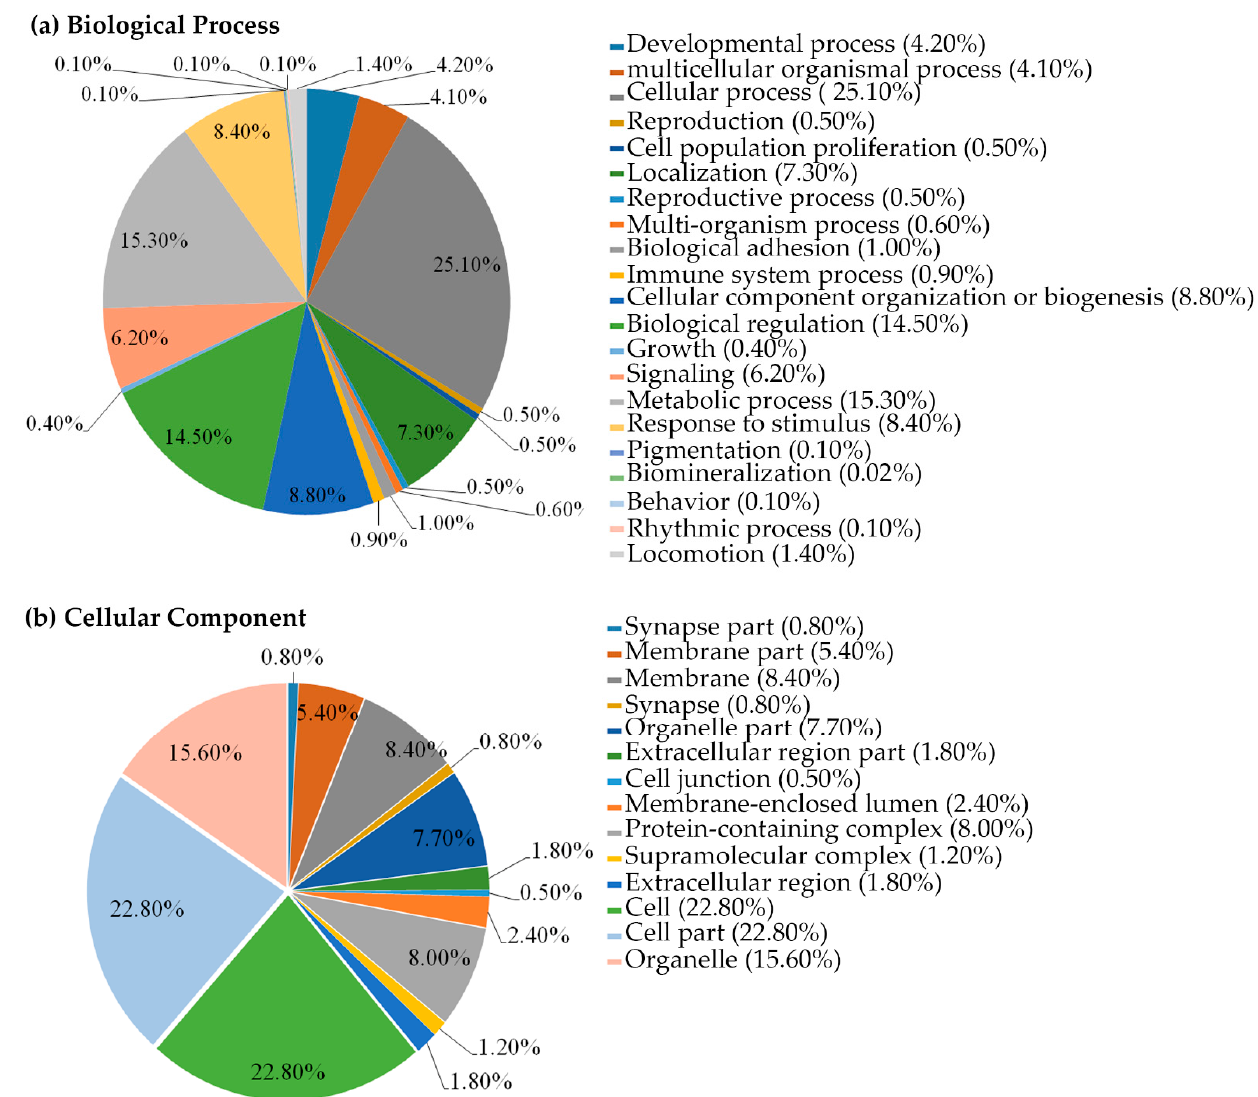
Figure 7. Gene-ontology (GO) functional annotation of biological processes and cellular components. The gene-ontology (GO) functional annotation of 3485 expressed proteins in TILI-2 untreated and treated cells were classified using the PANTHER classification system according to ( a ) biological processes and ( b ) cellular components.